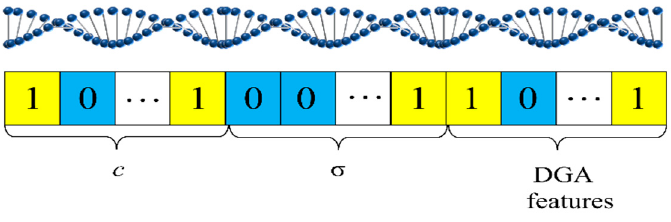
Figure 1. The binary encoding of chromosomes.